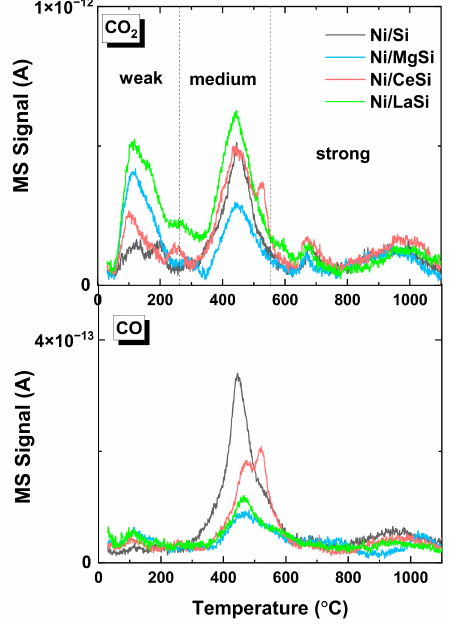
Figure 6. CO 2 -TPD profiles of the Ni/Oxide-SiO 2